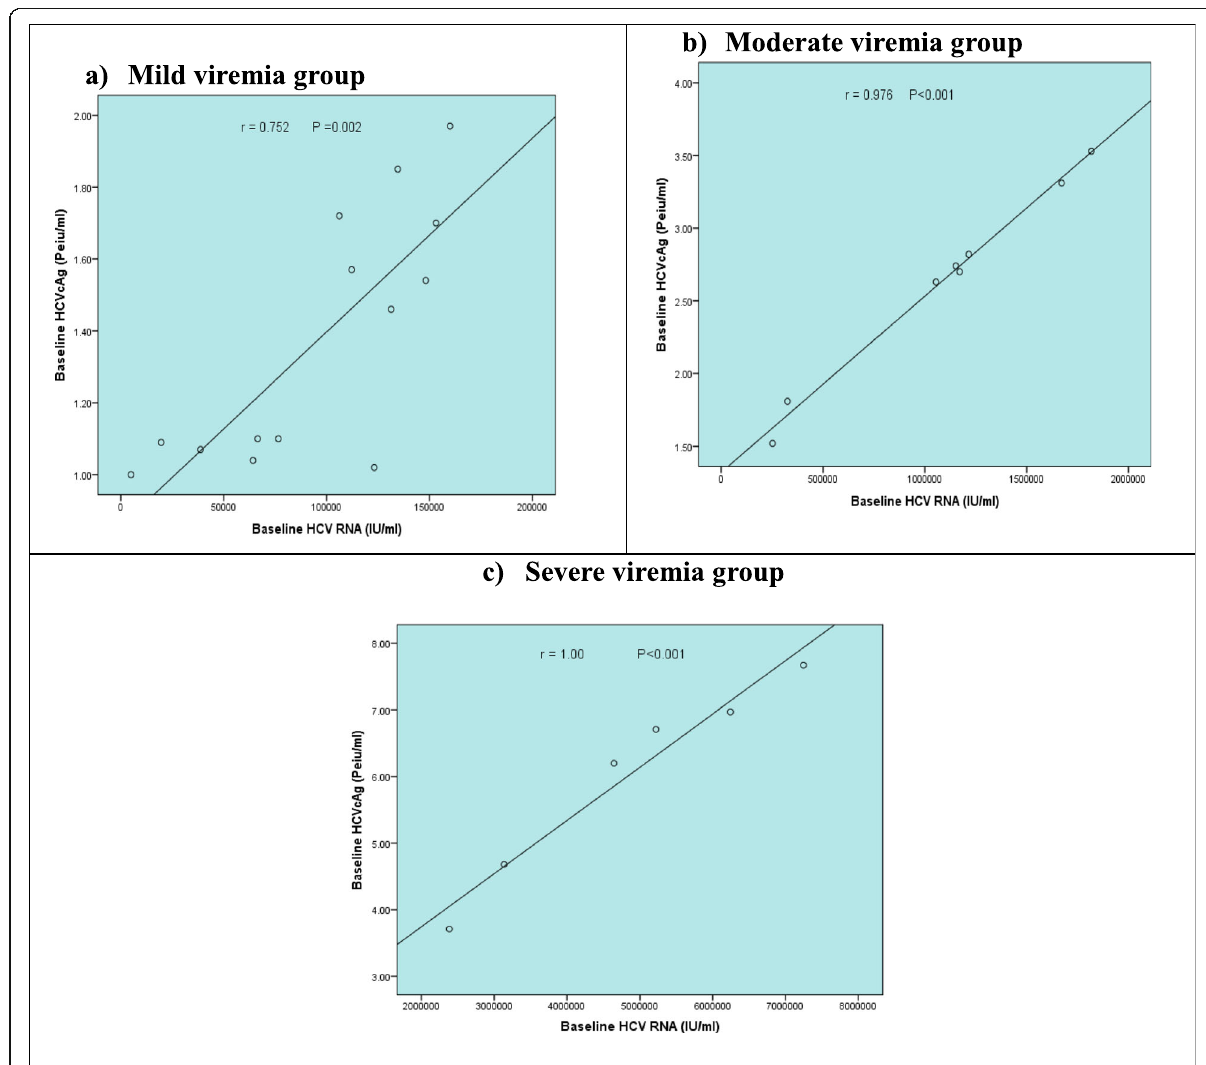
Fig. 3 a – c Correlation between baseline levels of HCVcAg (Peiu/ml) and HCV RNA (IU/ml) assays among the studied groups